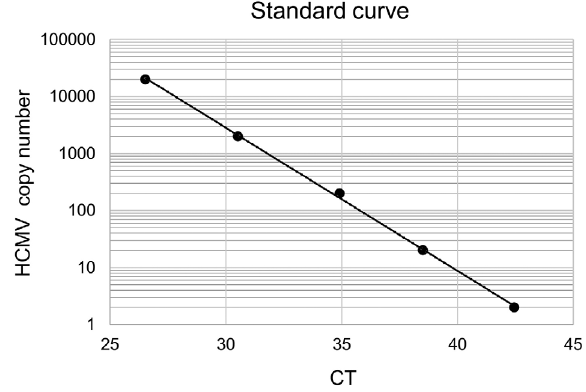
Figure 1- Standard curve indicating human cytomegalovirus (HCMV) copy number vs CT